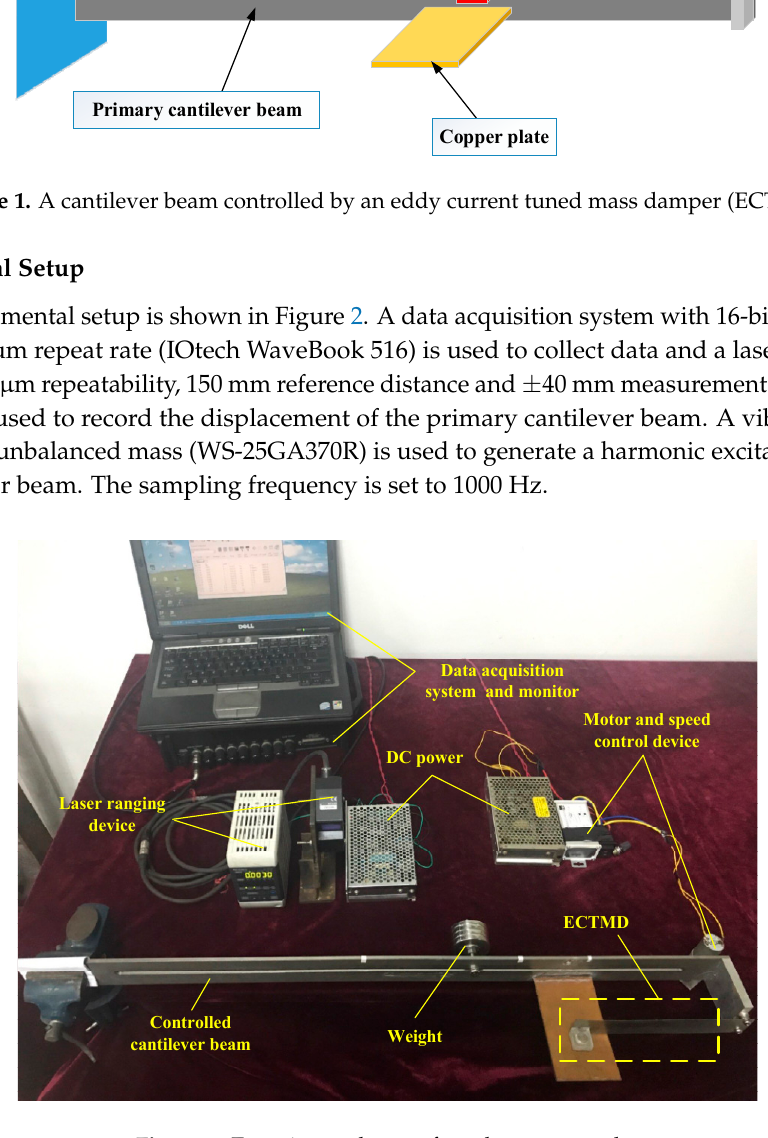
Figure 2. Experimental setup for robustness study.